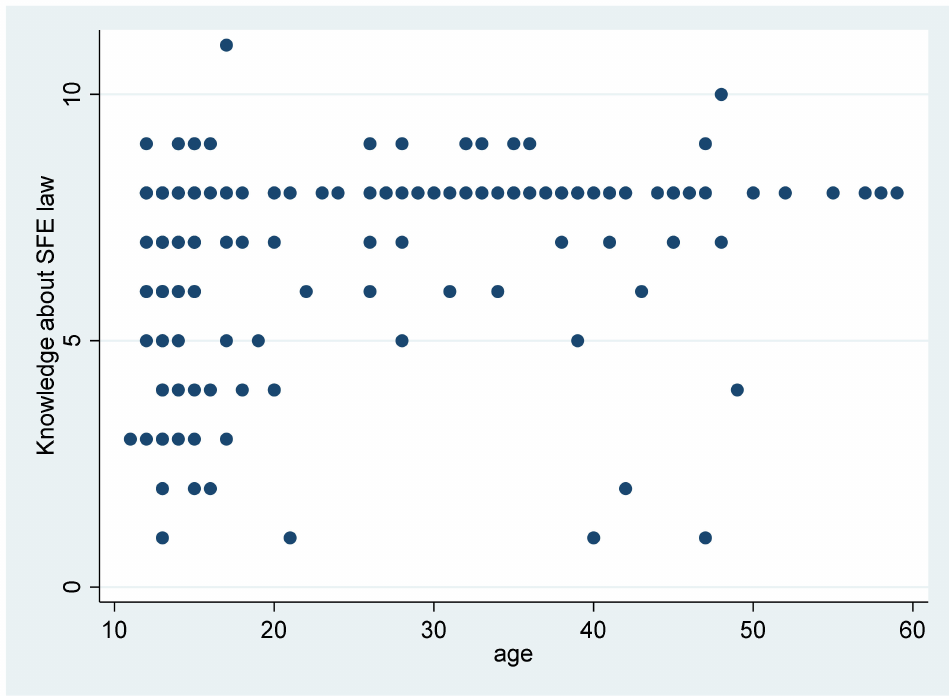
Figure 1. The adults on average answered more questions on the SFE law